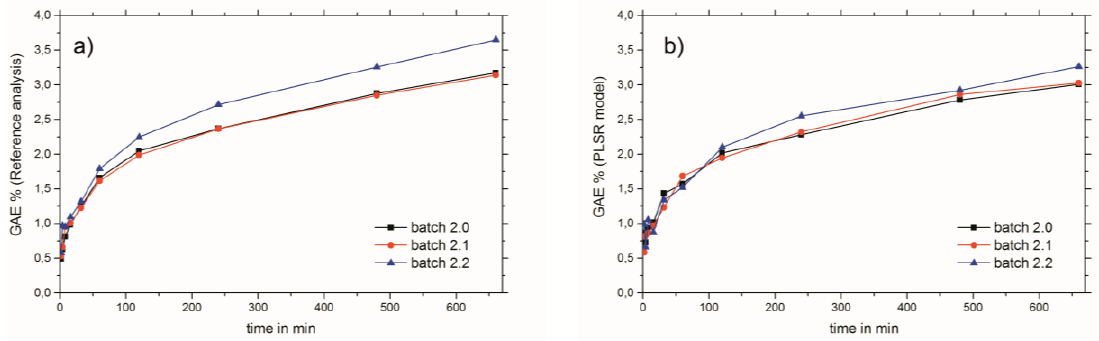
Figure 4. Monitoring of the extraction process of Rosmarini folium via ( a ) Folin–Ciocalteu reference analysis and ( b ) NIR spectroscopy.